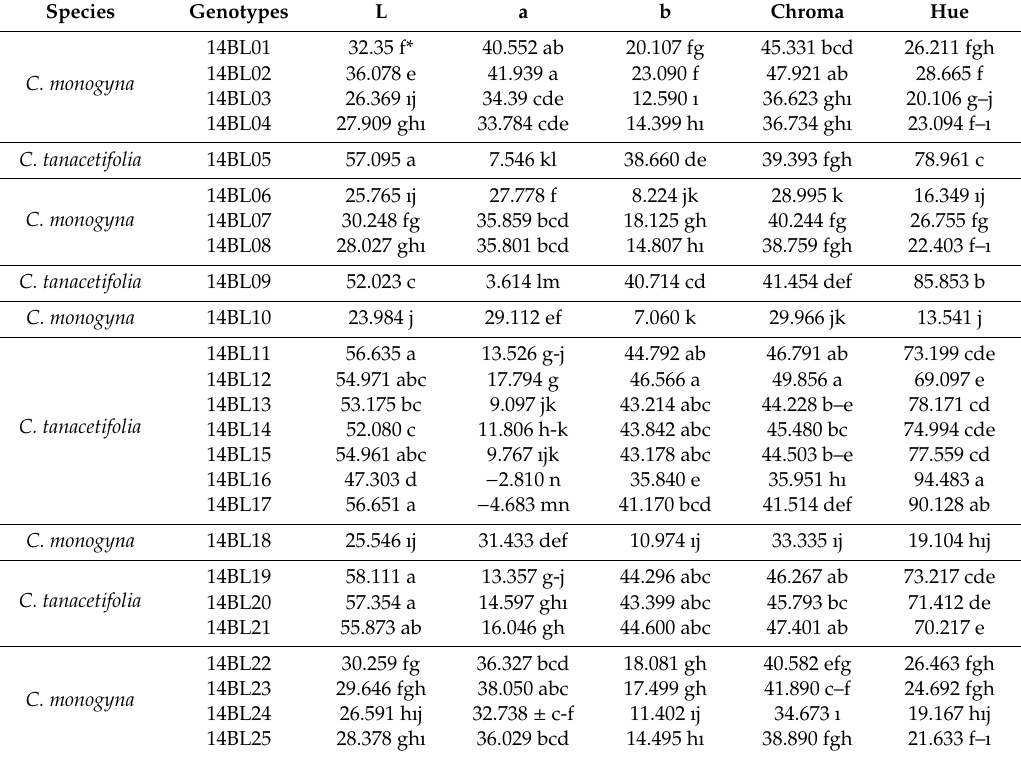
*: Different letters in same columns indicate significantly different values at p ≤ 0.05.